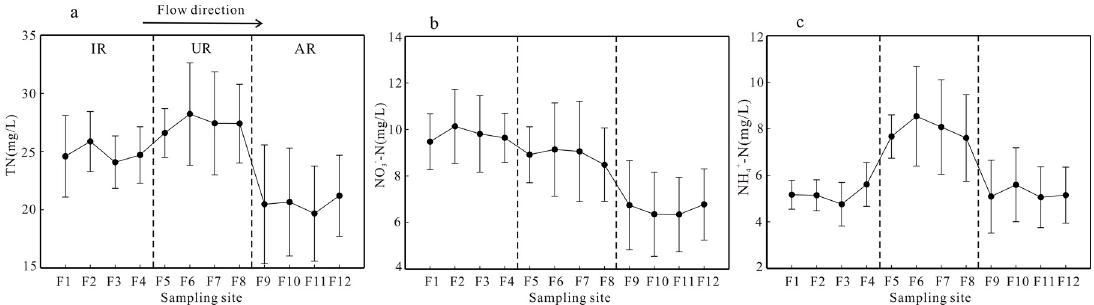
Figure 4. Spatial variation in ( a ) total nitrogen (TN), ( b ) NO 3 − –N, and ( c ) NH 4+ –N concentrations in the lower reach of Fenhe River. The error bars represent standard deviation. IR: industrial region; UR: urban region; AR: agricultural region.